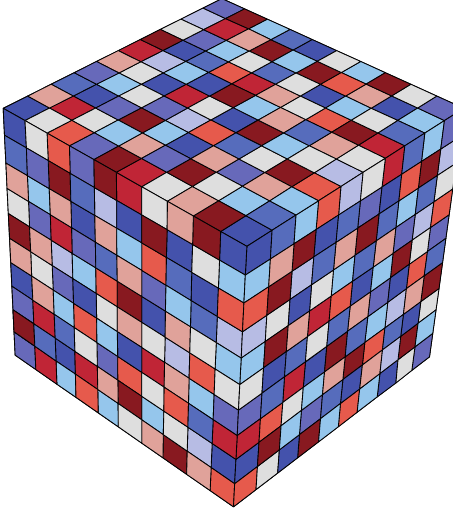
Figure 1. A realisation of the n-phase composite investigated in this